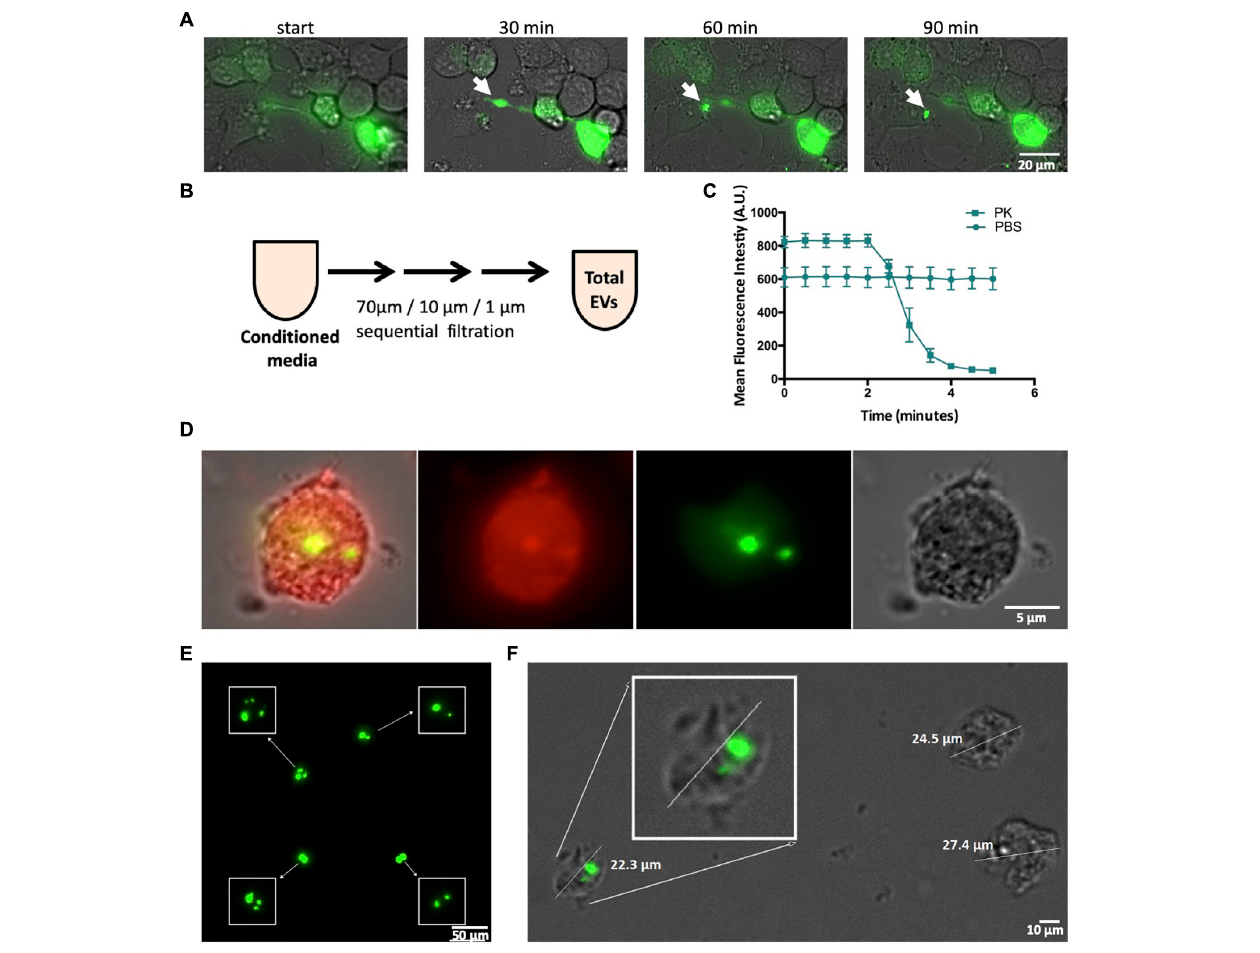
FIGURE 3 | CSP α export of 10–30 µ m EVs. (A) Widefield time lapse fluorescent microscopy with brightfield of EV export containing GFP-tagged huntingtin aggregates from a donor cell. (B) Experimental approach, EVs were examined following filtration. (C) EVs were treated with 0.01 mg/ml proteinase K () or PBS () and fluorescence monitored over time. (D) Deep red membrane stain of an EV containing GFP-tagged huntingtin aggregates. (E) High-resolution, fluorescence deconvolution microscopy of GFP-tagged huntingtin aggregates located in EVs. (F) Size of EVs exported from CAD